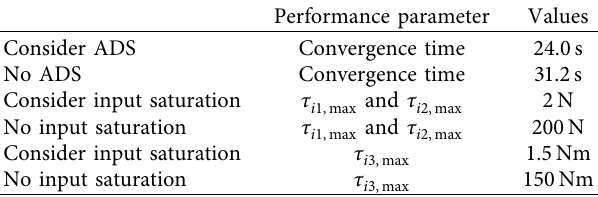
Table 3: Specific values of simulation test and comparison test.